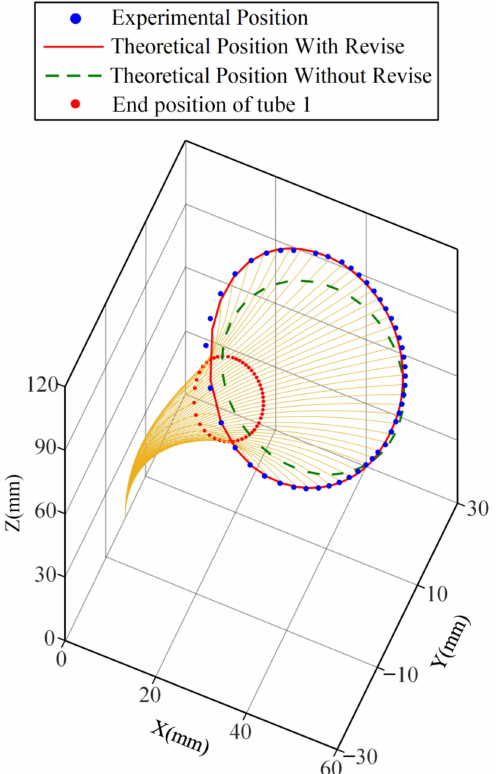
Figure 9. Comparison of the inner tube rotation path of the improved model and the previous model.